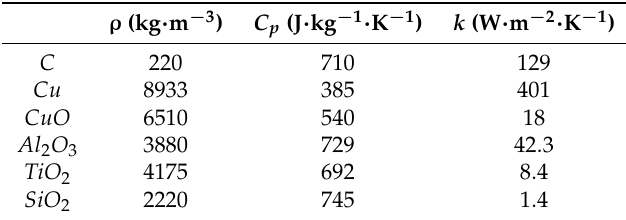
Table 1. Thermophysical properties of different types of